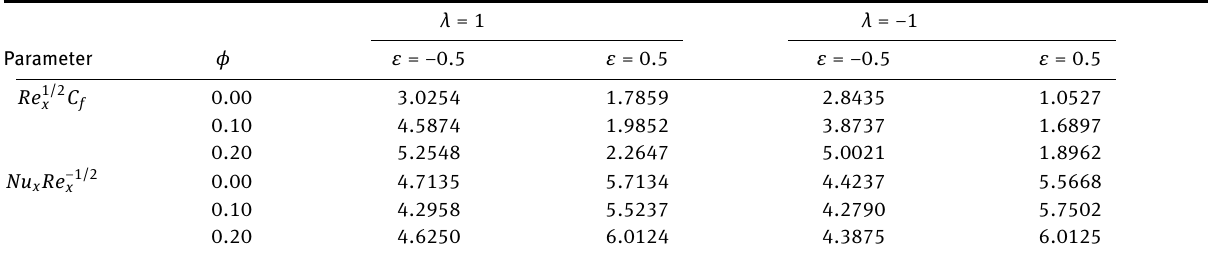
Table 7: The effect of the nanoparticle volume fraction on the skin friction coefficient and local Nusselt number for titania-sodium alginate nanofluid with A = 0.5, M = 1, U